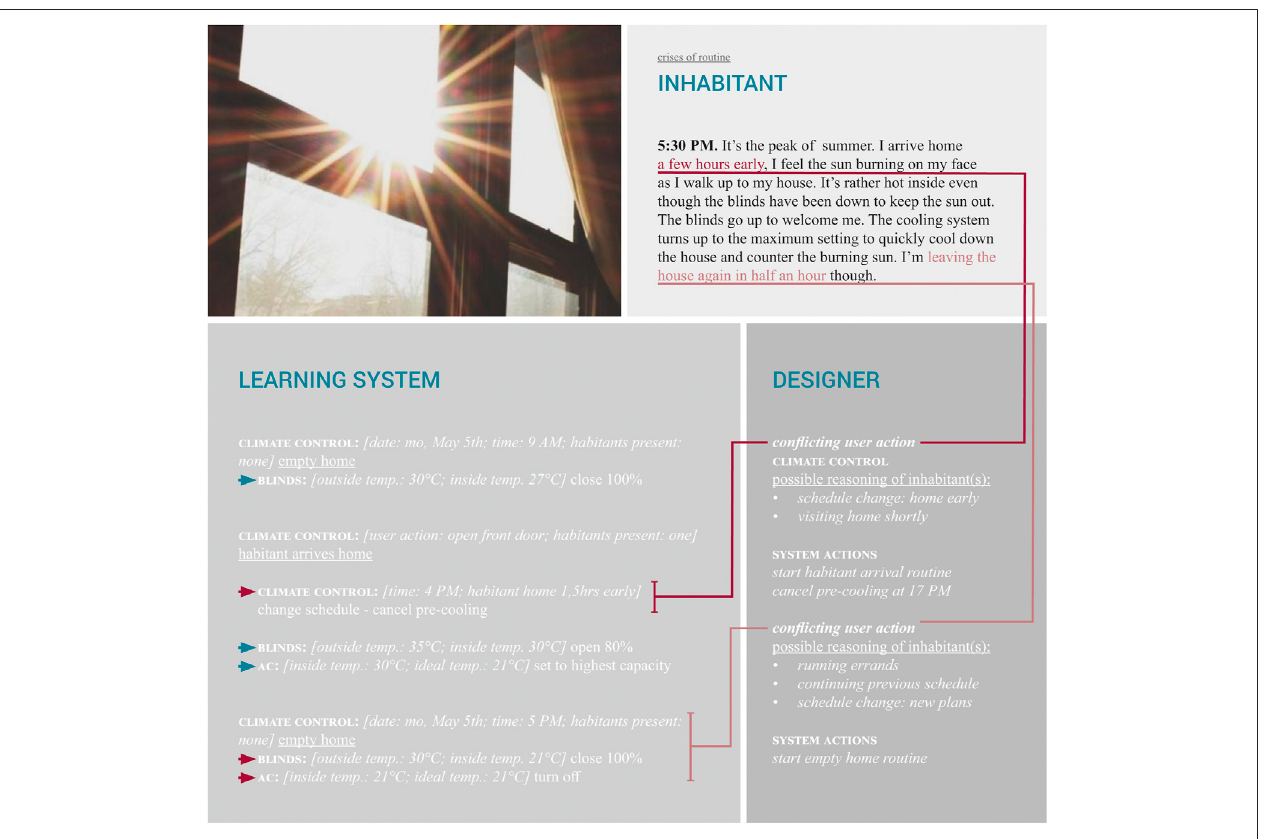
FIGURE 6 | Heating and cooling: crises imaginary (photo by Vermeersch,